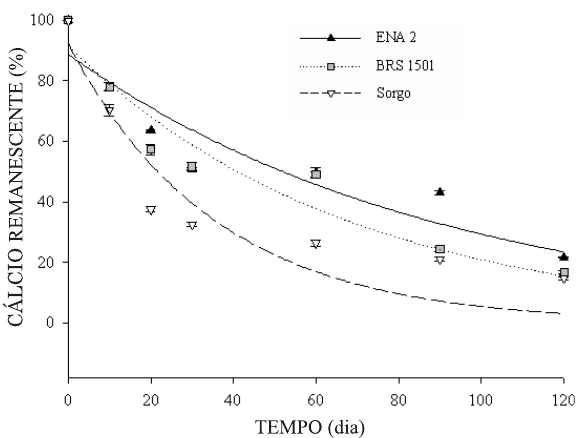
Figura 5. Teores de cálcio na matéria seca remanescente das plantas de cobertura em avaliações realizadas ao longo do tempo em bolsas de decomposição na superfície do solo (A equação e a significância dos ajustes estão apresentadas no Quadro 2).